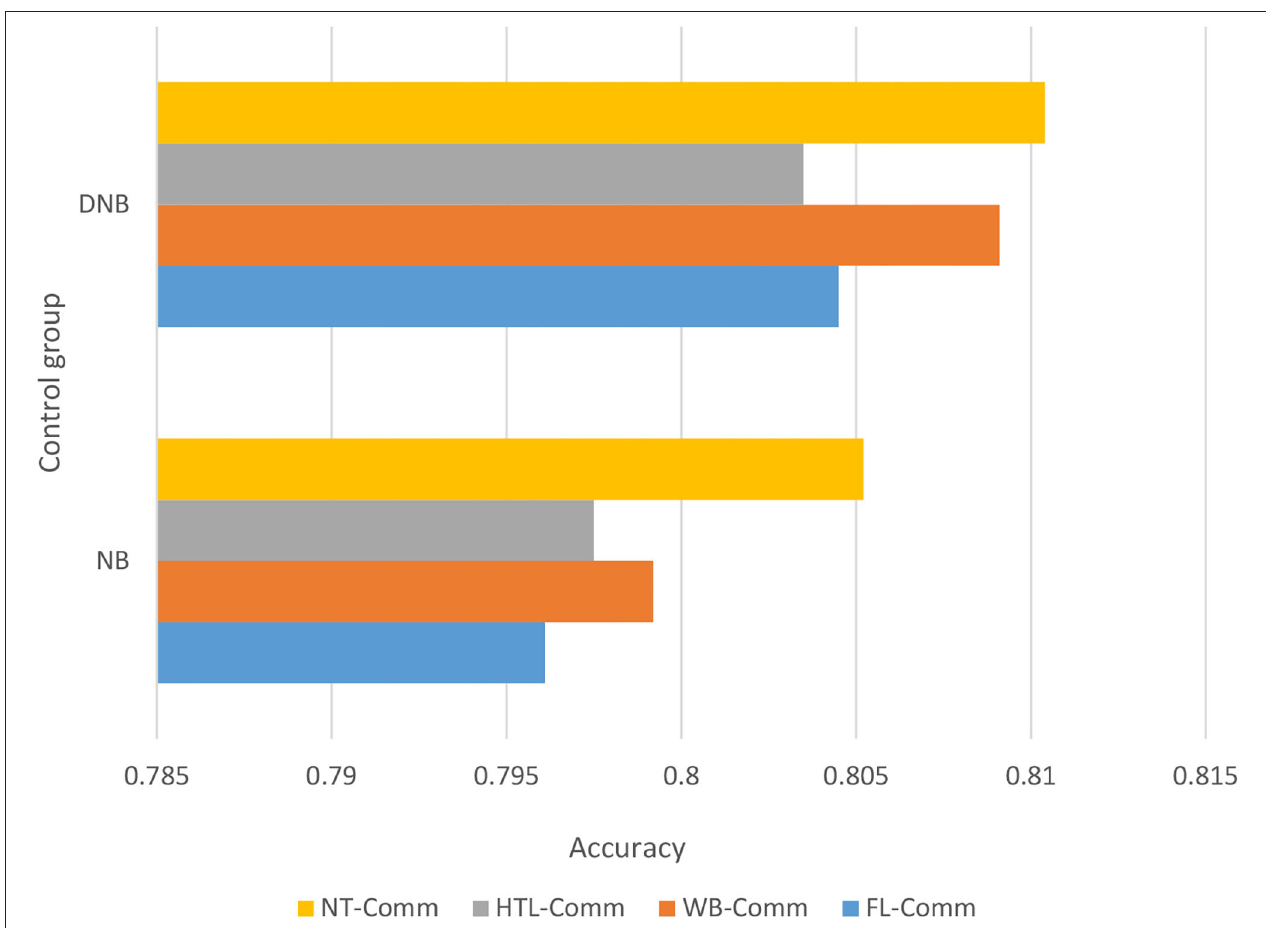
FIGURE 7 | Comparison of accuracy of different classifiers on different data